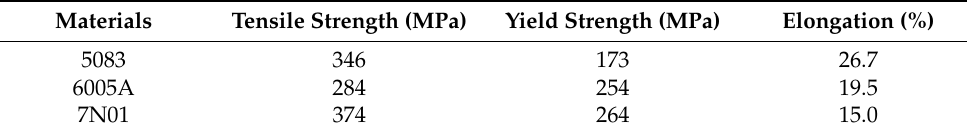
Table 2. As-received mechanical properties of the base